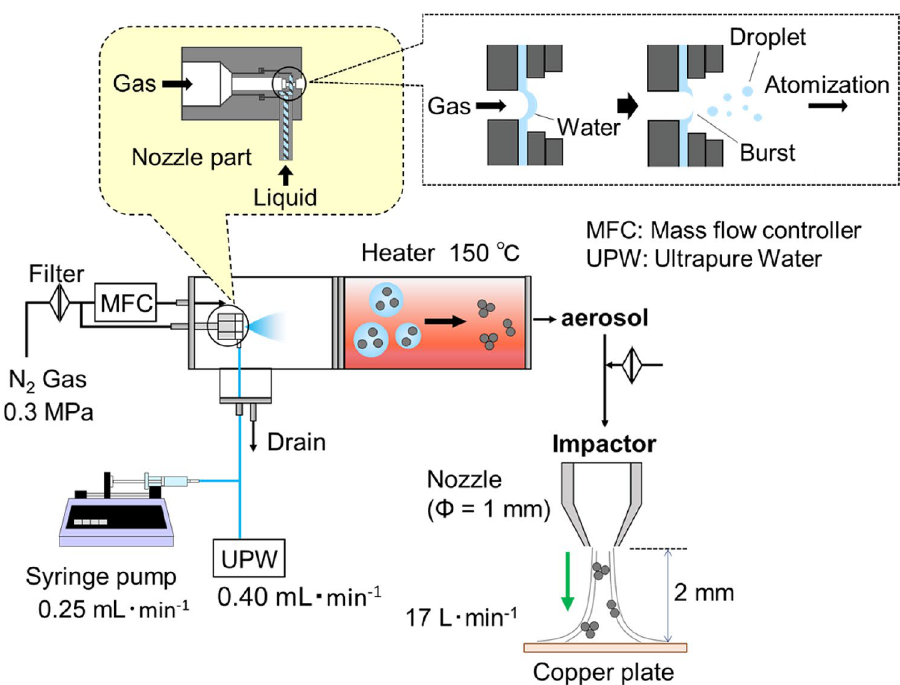
Figure 1. Schematic of an atomization system for the fabrication of aggregated silver